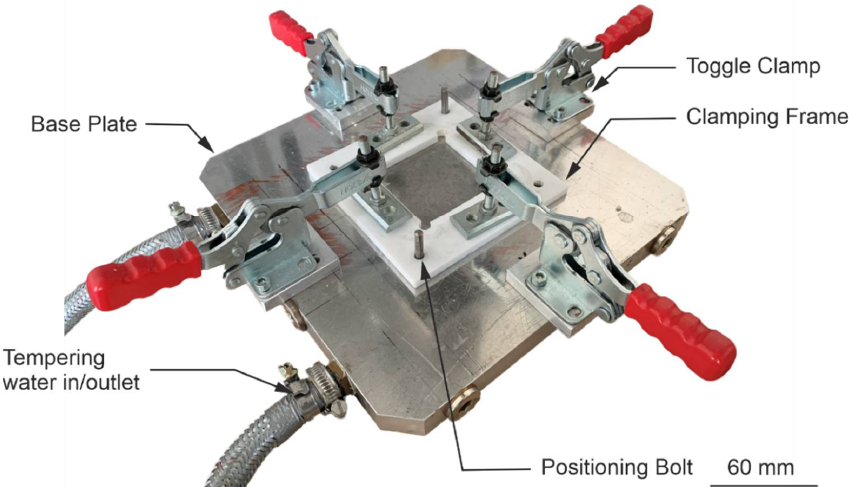
Figure 1. Clamping device (original photo).